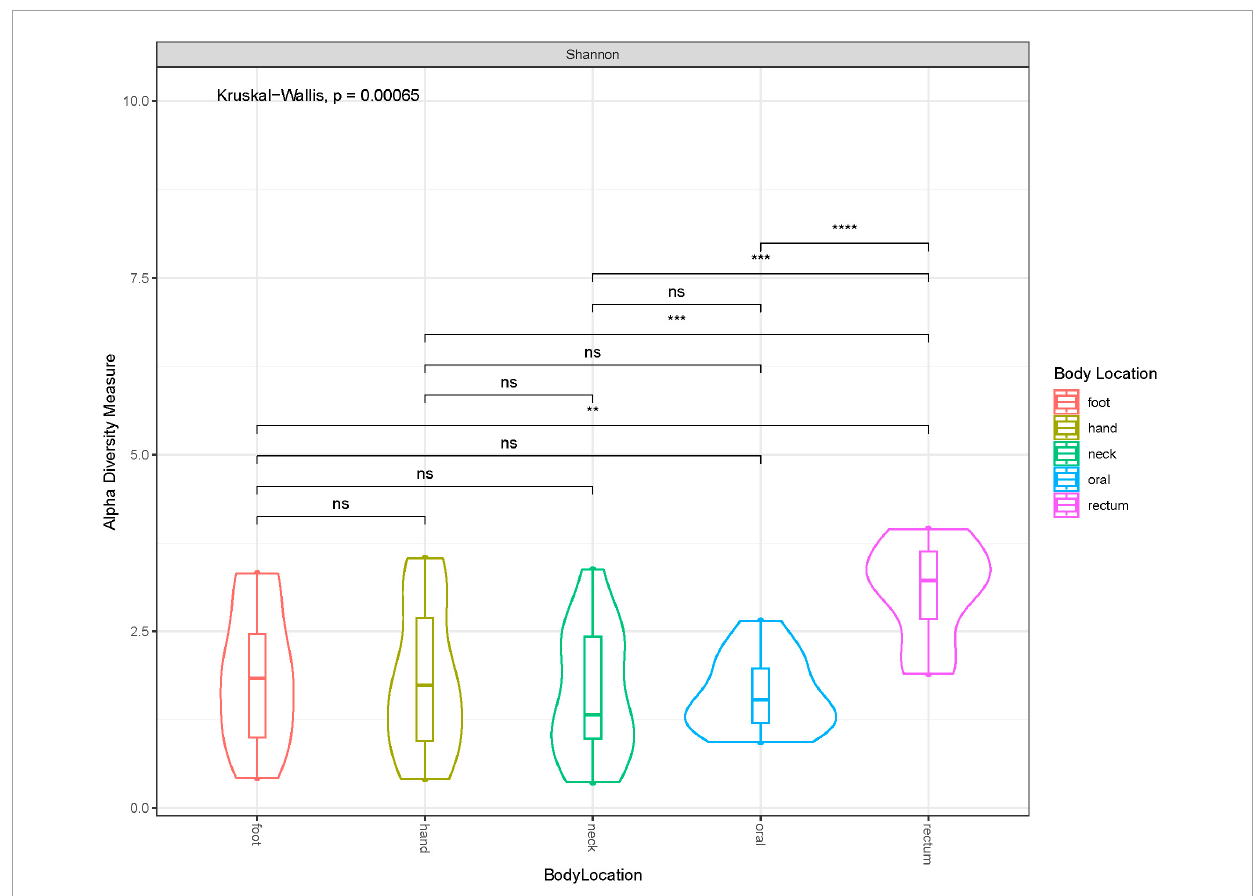
FIGURE3 Violin plot showing Shannon diversity at each anatomical location at ASV level. * less than or equal to 0.01; ** less than or equal to 0.001; *** less than or equal to 0.0001.